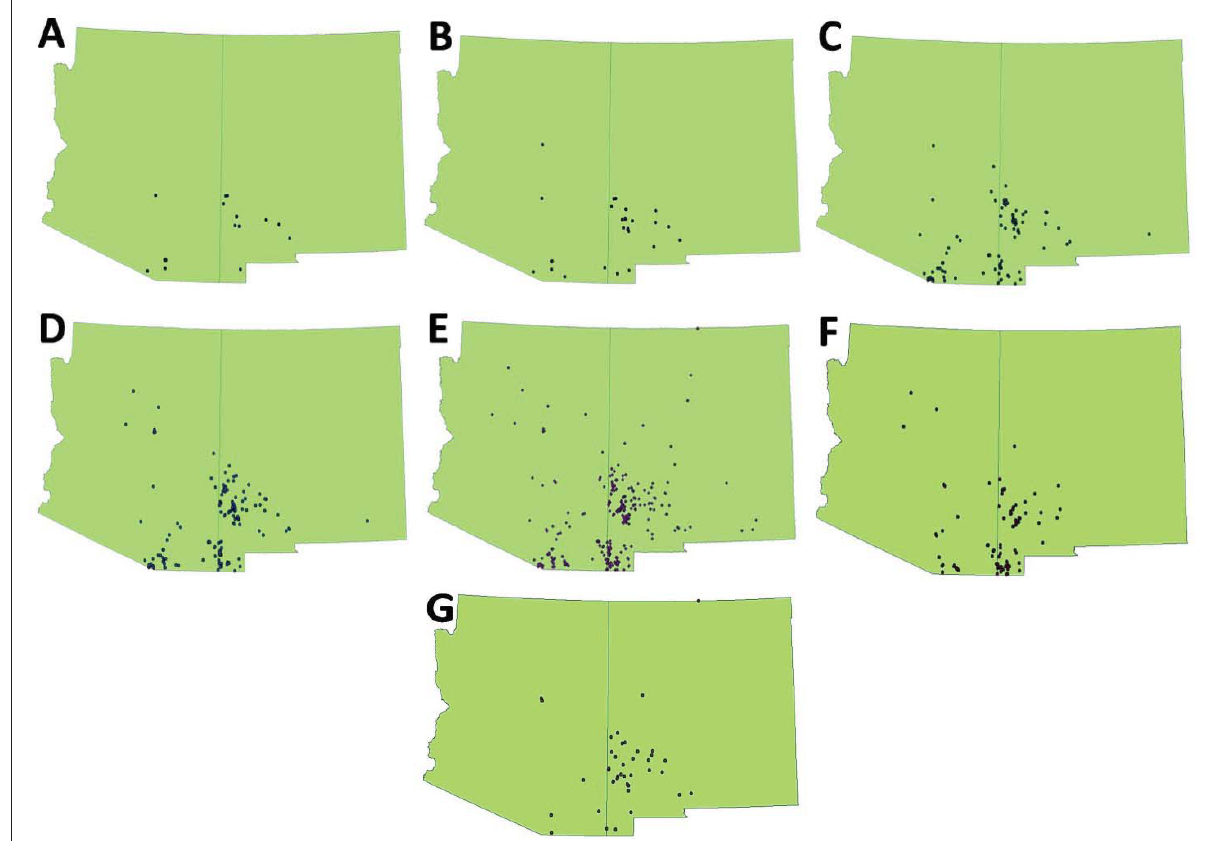
Figure 1. Comparison of subsets of occurrence records that differ in reliability and precision (see Tables 3 and 4) for the white-nosed coati ( Nasua narica ) in Arizona and New Mexico: ( A ) very conservative, ( B ) conservative, ( C ) best a priori, ( D ) moderate, ( E ) liberal, ( F ) poor precision, ( G ) poor